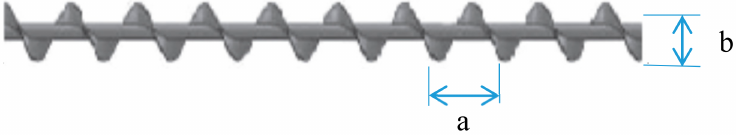
Figure 6. Diagram of the helical screw